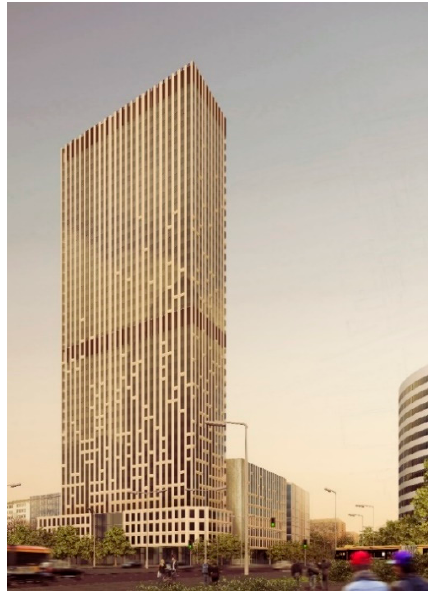
Figure 15. Final concept model based on the conducted analysis.